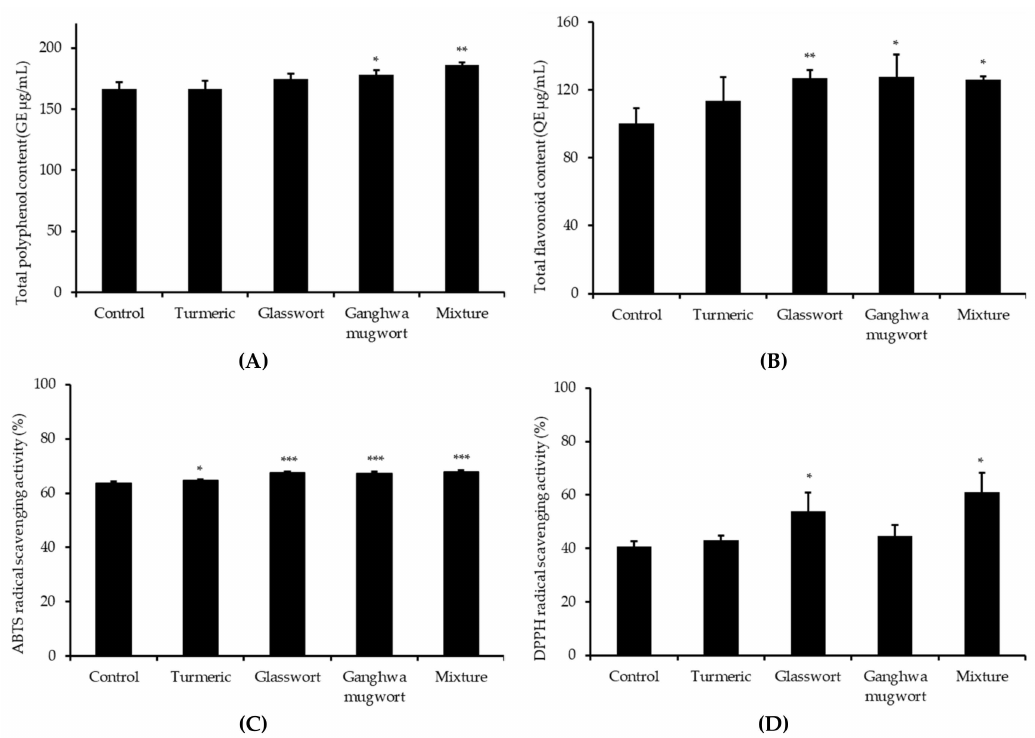
Figure 4. ( A ) Total polyphenol content (GE µ g / mL), ( B ) Total flavonoid content (QE µ g / mL), ( C ) ABTS radical scavenging activity, and ( D ) DPPH radical scavenging activity of dog foods. The samples were MeOH extracts with 1:3 ground dog food:80% MeOH. * p < 0.05, ** p < 0.01, *** p <